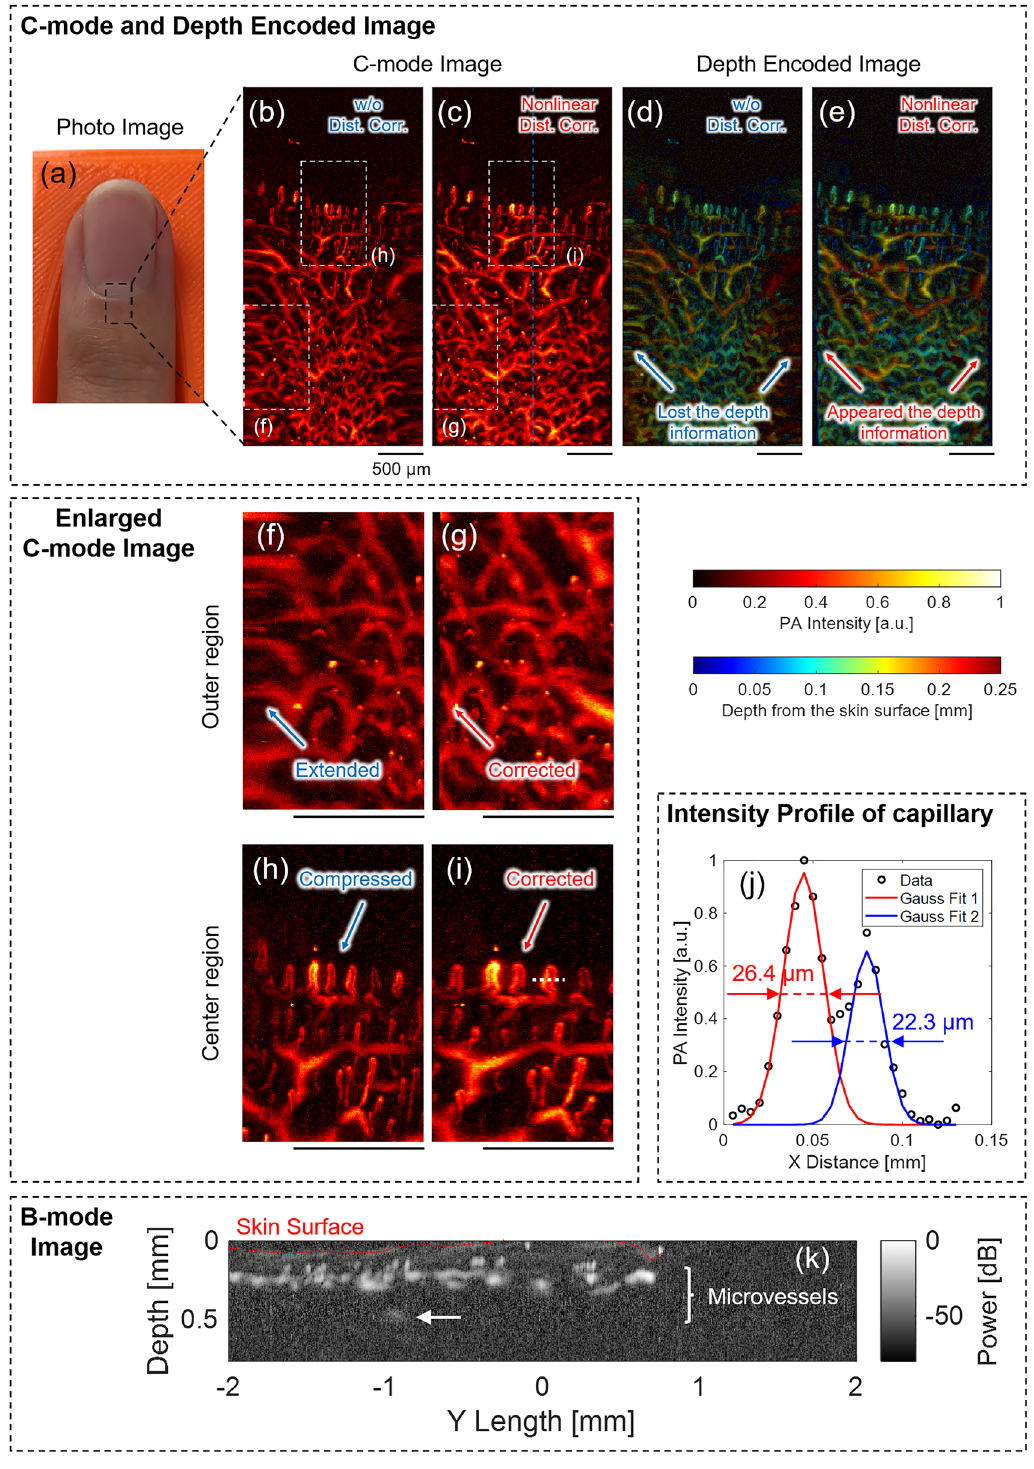
Figure 8. Result of microvascular imaging of human finger. ( a ) Photo image. ( b,c ) C-mode image: ( b ) without distortion correction, and ( c ) with nonlinear distortion correction. ( d,e ) Depth encoded image: ( d ) without distortion correction, and ( e ) with nonlinear distortion correction. ( f,g ) Enlarged C-mode image in the outer region of ( b,c ): ( f ) without distortion correction and ( g ) with nonlinear distortion correction. ( h,i ) Enlarged C-mode image in the center region of ( b,c ): ( h ) without distortion correction and ( i ) with nonlinear distortion correction. ( j ) PA intensity profile along the white dotted line in ( i ). ( k ) B-mode image along the blue dotted line in ( c